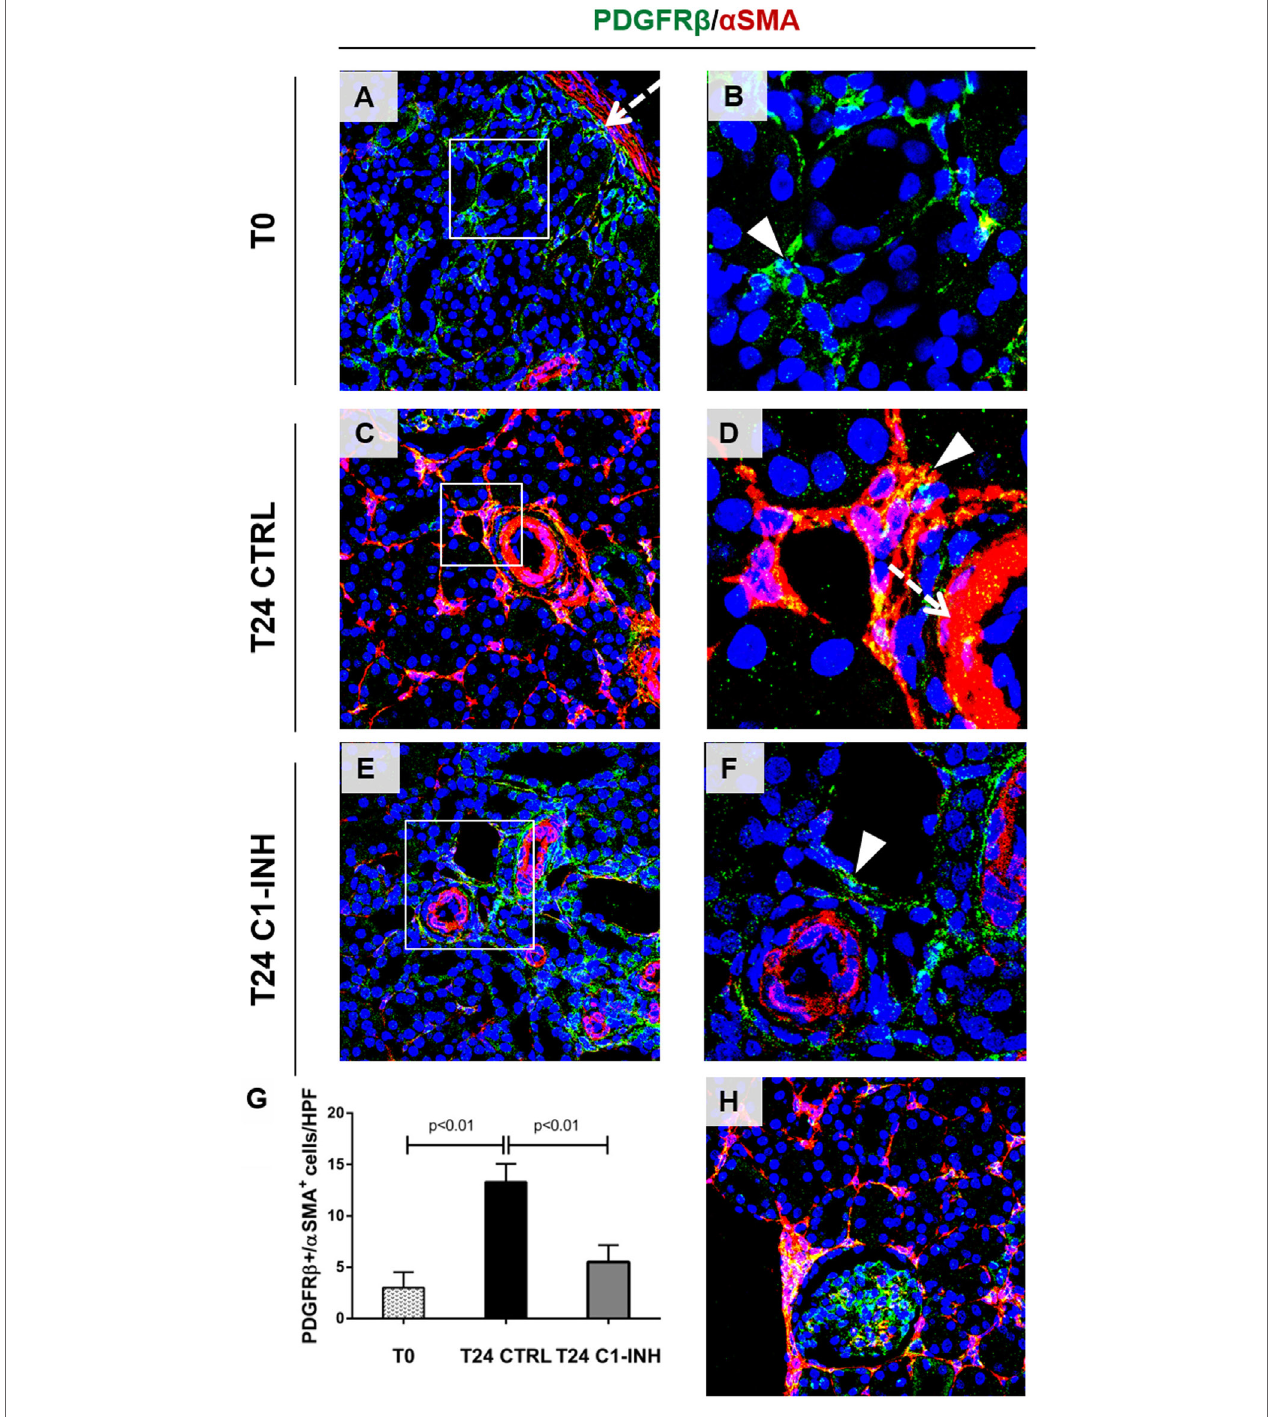
FigUre 4 | C1-INH significantly modulate the occurrence of PMT in Vivo . Confocal images showing interstitial peritubular capillaries pericytes co-labeled with PDGFR β (green) and α SMA (red). In T0, PDGFR β + / α SMA + perivascular cells were barely detectable [ (a) , boxed area was zoomed in (b) ], and α SMA was localized in the wall of arteries [dotted arrows (a,D) ]. After 24 h of ischemia/reperfusion injury [ (c) , rectangle area was zoomed in (D) ], the number of PDGFR β + / α SMA + cells increased predominately at peritubular capillaries level [ (D) , arrowhead]. C1-INH treatment limited the α SMA increase (e,F) . The PDGFR β decrease occurred at peritubular capillary level and did not affect the PDGFR β + -mesangial cells [T24 CTRL in (h) ]. Results are expressed as median ± interquartile range of the numbers of PDGFR β + / α SMA + cells/high power fields (HPF) of five independent pigs for each group (g) . Magnification, 630 ×